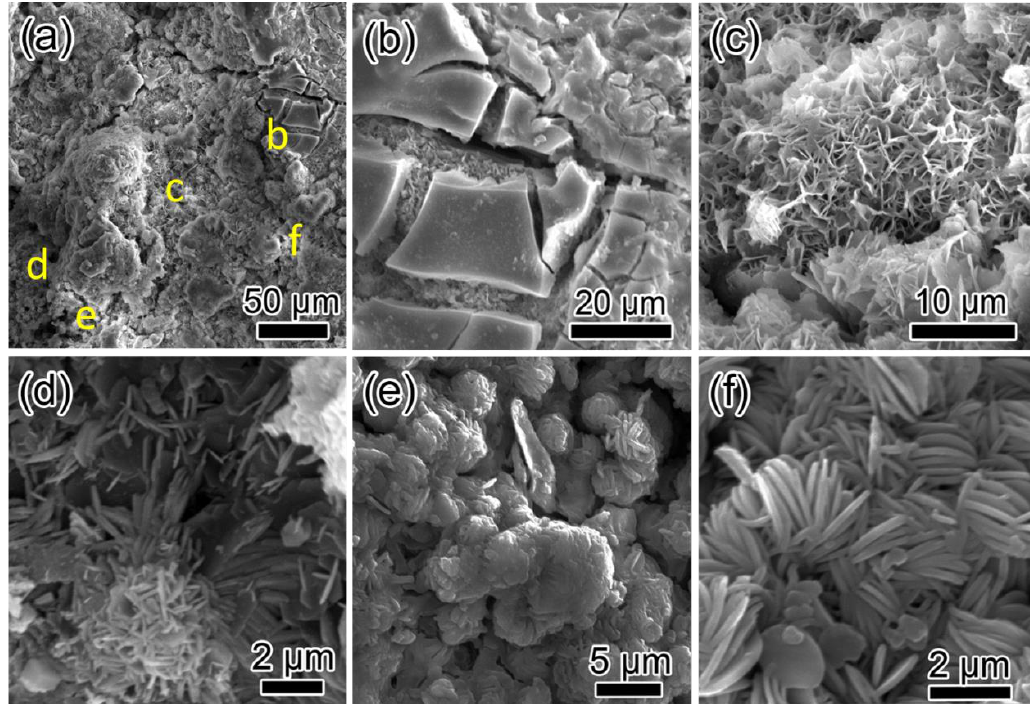
Figure 7. The morphologies of Zn–Al coating’s corrosion products after a 200-day salt spray test: ( a ) macroscopic morphologies of the combined corrosion products, in which position b–f represent different corrosion products; ( b ) Zn 6 Al 2 (OH) 16 CO 3 ·4H 2 O; ( c ) Zn 5 (OH) 8 Cl 2 ·H 2 O; ( d ) high-magnification image of Zn 5 (OH) 8 Cl 2 ·H 2 O; ( e ) Zn 5 (CO 3 ) 2 (OH) 6 ; ( f ) high-magnification image of Zn 5 (CO 3 ) 2 (OH) 6 .